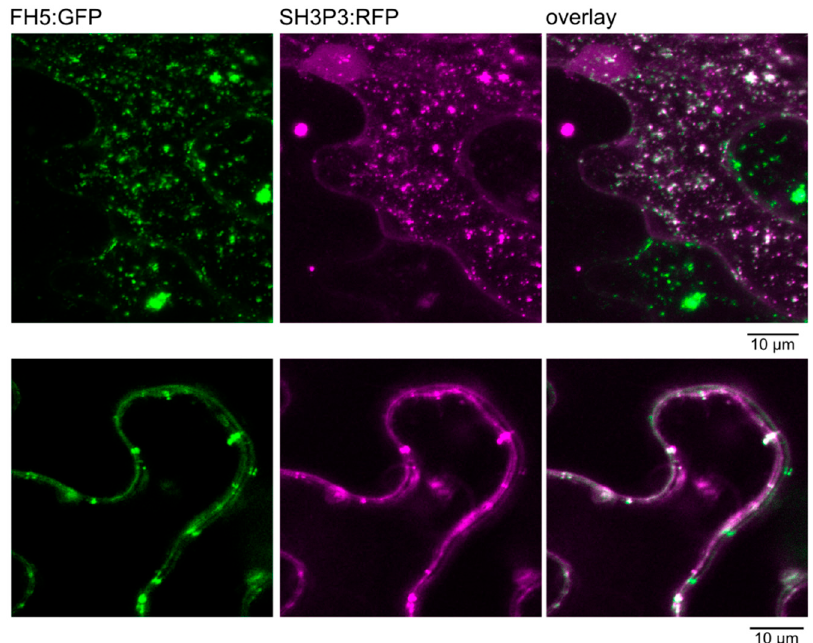
Figure 3. Co-localization of FH5, C-terminally tagged by green fluorescent protein (GFP), with SH3P3, C-terminally tagged by red fluorescent protein (RFP), in transiently transformed N. benthamiana leaf epidermis, as documented by confocal laser scanning microscopy. Note the cell exhibiting only GFP fluorescence and the weak nuclear RFP signal, indicating absence of cross-channel signal leak. Top: Maximum intensity projection of a Z-stack of optical sections across an epidermal pavement cell. Bottom: A single confocal section showing a detail of an anticlinal cell to cell boundary.